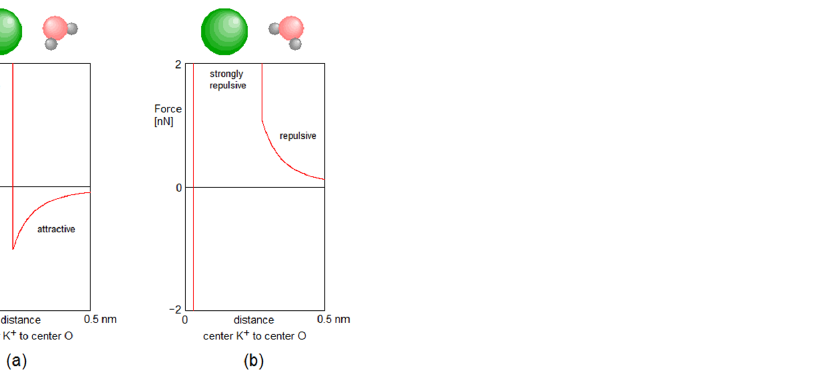
Figure A1. Force between a K + ion and a water molecule as a function of distance. ( a ) The negative oxygen atom of the water molecule points towards the positive K + ion. As long as the distance between the center of K + and of the water molecule is larger than 0.248 nm (about 90% of the sum of the radius of K + and the effective radius of H 2 O), the total coulomb force between the K + and the three charges of the water molecule is attractive with a maximum magnitude of almost 10 − 9 N. Within the repulsion zone an extremely strong repulsive force sets in, however. This configuration occurs when the water molecule is part of a hydration shell of the K + ion. When this configuration occurs within the selectivity filter, which is often the case when a water molecule from the inner cell cavity follows a K + ion into the selectivity filter, the water molecule becomes attached to the K + and moves with it through the selectivity filter. ( b ) One positive hydrogen atom of the water molecule points towards the positive K+ ion. Here the total Coulomb force between the K + and the water molecule is always repulsive, but at a distance of 0.5 nm it has fallen off to only about 2 × 10 − 10 N. However, if the water molecule and the K + approach closer than the repulsion zone and the elec- tron shells begin to overlap, the very strong repulsion force sets in.